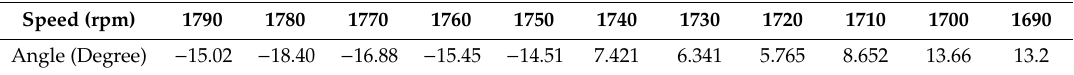
Table 3. LDA direction information for each